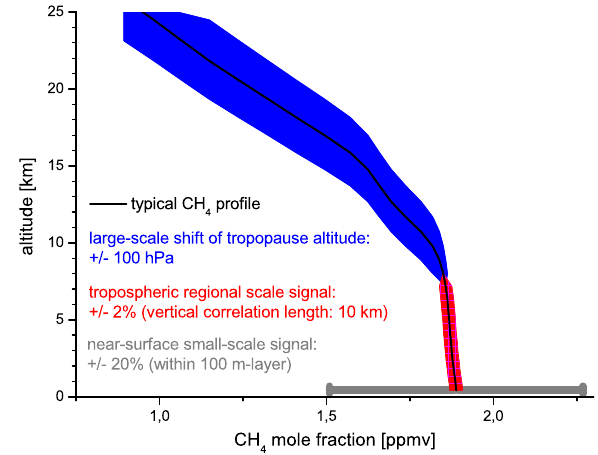
Fig. 1. Typical atmospheric CH 4 signals. Grey bar: near-surface small-scale variability; red area: tropospheric regional-scale variability; blue area: UTLS variability caused by large-scale shifts in the tropopausealtitude.